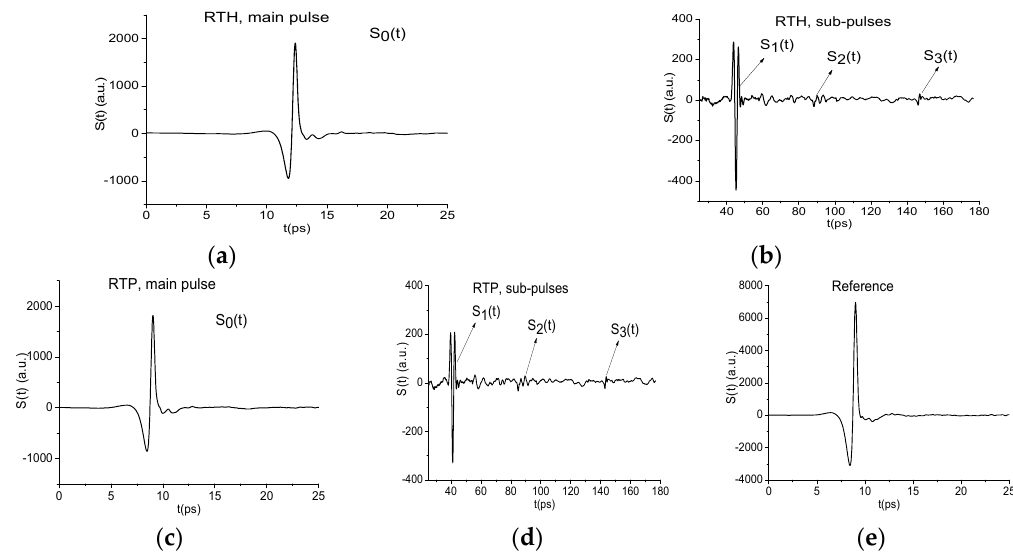
Figure 1. Reflected THz RTH ( a , b ) and RTP ( c , d ) signals measured in the time intervals t = [0, 25] ps ( a , c ) and [25, 180] ps ( b , d ). Reference is measured in the time interval t = [0, 25] ps ( e ).